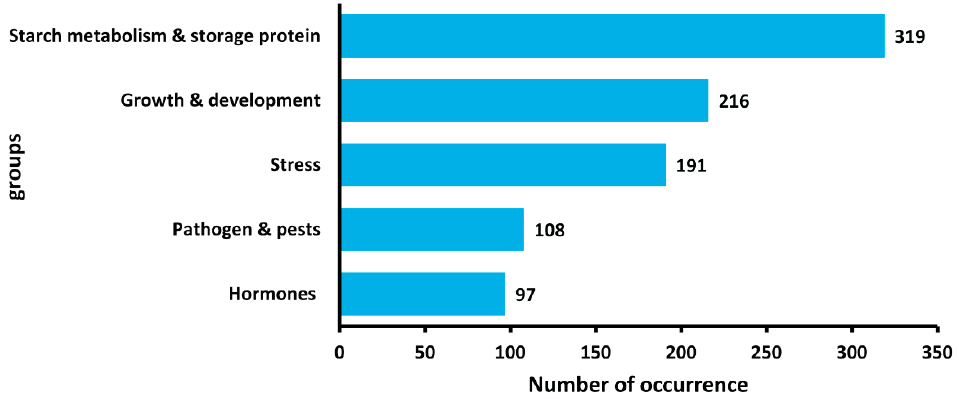
Figure 6. Cis -elements in 2000-bp upstream of StNF-YC4 are grouped into five major categories according to their predicted functions. PlantCARE and PLACE were used to identify these cis -elements in StNF-YC4 promoter regions [48,49] .